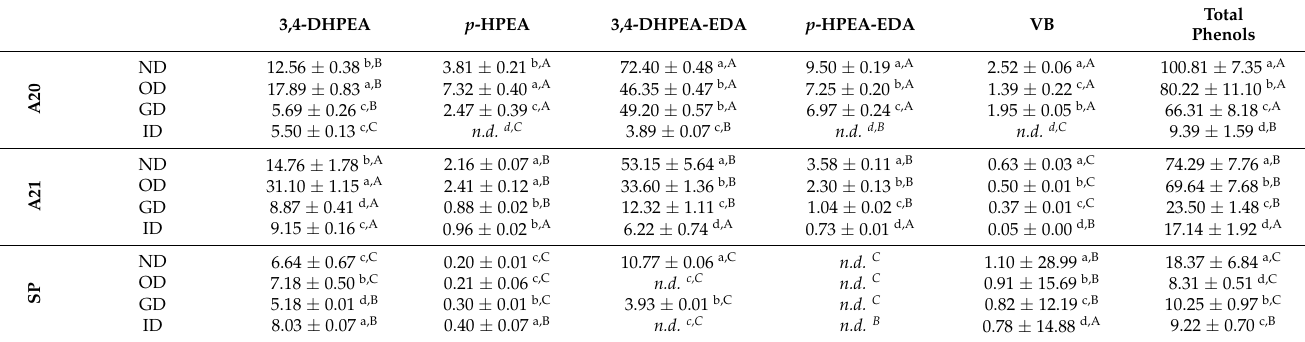
Table 2. Effect of in vitro on the phenolic content (expressed as AU × 10 6 ) of 3 phenolic